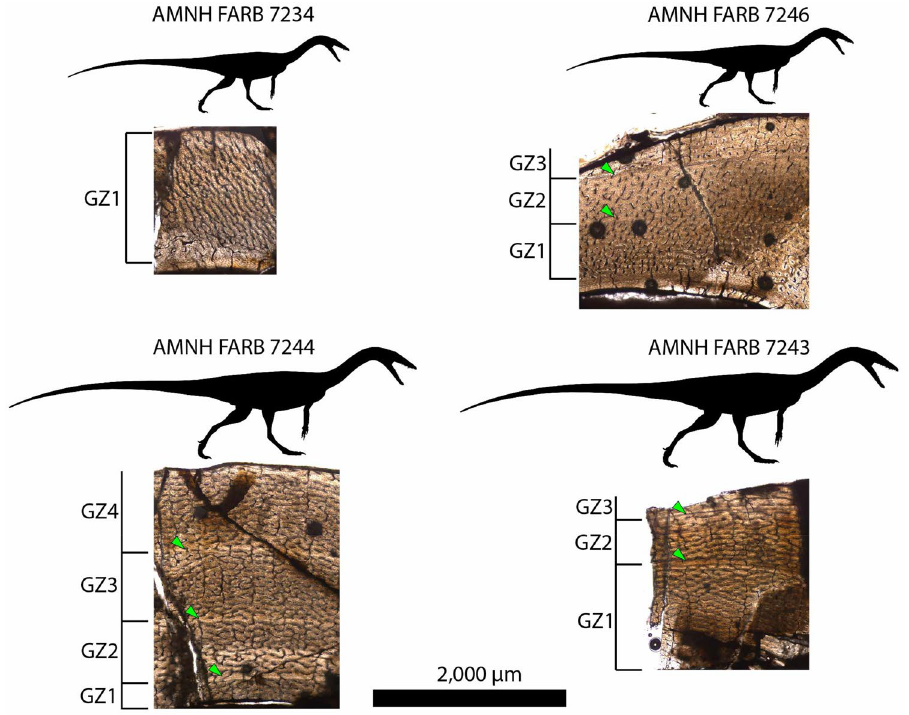
Figure 2. Representative Coelophysis bauri tibia thin sections from the Coelophysis Quarry at Ghost Ranch, New Mexico. All thin sections are presented at the same scale. Silhouettes were scaled to the femur length of the specimen. Green triangles point to growth marks (LAGs and annuli) that define growth zones (GZ). Silhouettes by Scott Hartman (phylopic.org, Made available through a CC BY 3.0 license https:// creat iveco mmons. org/ licen ses/ by/3.